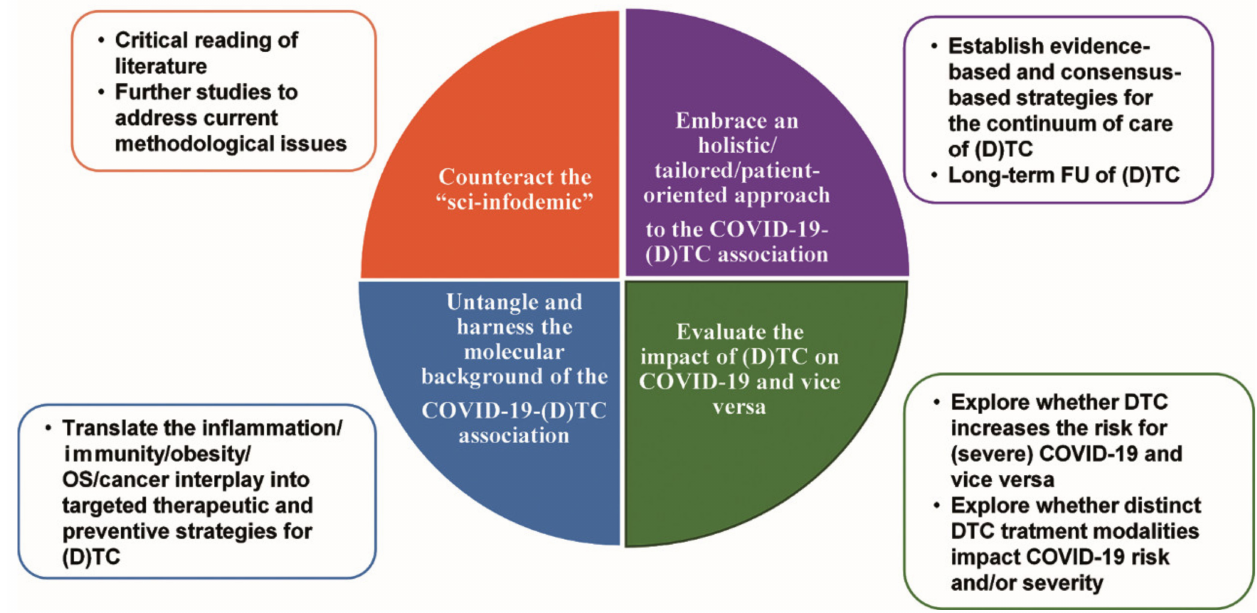
Figure 4. The main future perspectives in understanding and harnessing the COVID-19–(D)TC association. Abbreviations: COVID-19, coronavirus disease 19; (D)TC, (differentiated) thyroid cancer; FU,